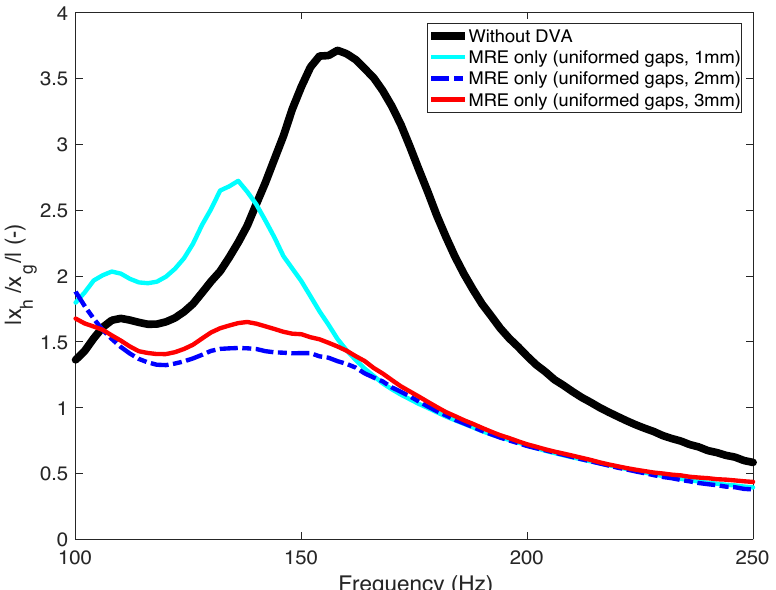
Figure 14. Comparison of the minimum envelopes of the vibration isolation performances of the Figure 10: Comparison on the minimum envelopes of the vibration isolation performances MRE-DVAs for three different MRE pad thicknesses. for three different MRE pad gaps.